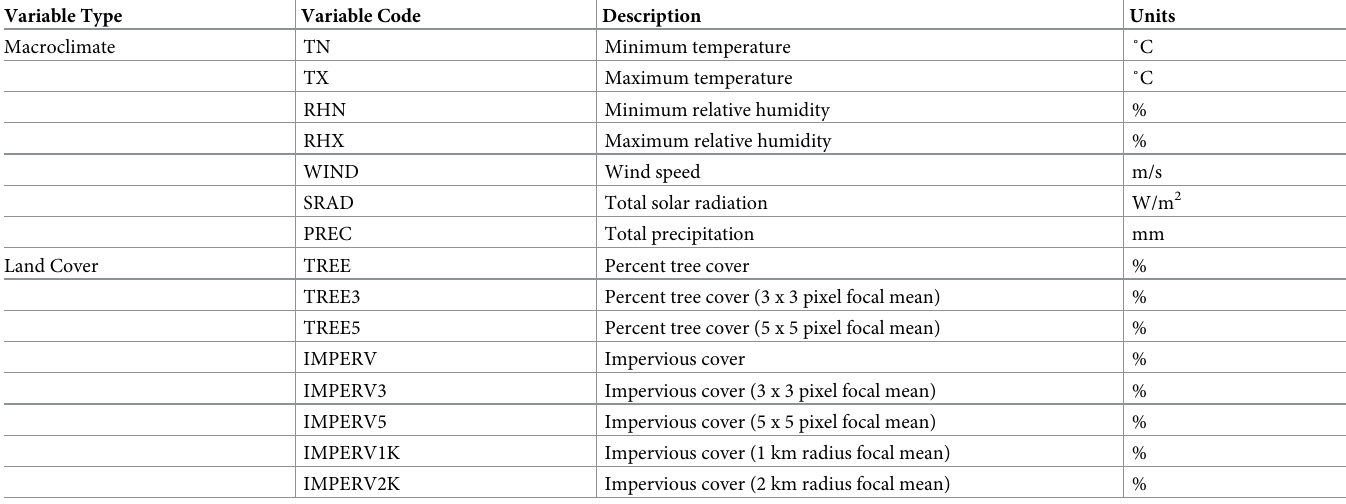
Table 1. Predictor variables considered in the development of linear models to predict microclimate temperatures based on macroclimate and land cover. Variable